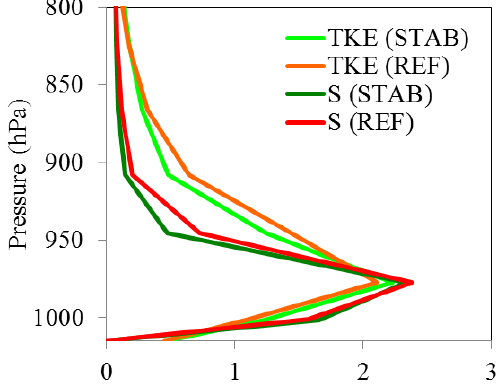
Figure 11. Vertical profiles of turbulent kinetic energy (TKE, in m 2 s − 2 ) and the stability function (dimensionless) are shown in the stratocumulus regime. The red and orange lines are for the ECHAM6-HAM2 reference simulation, and the light- and dark- green lines are for the STAB